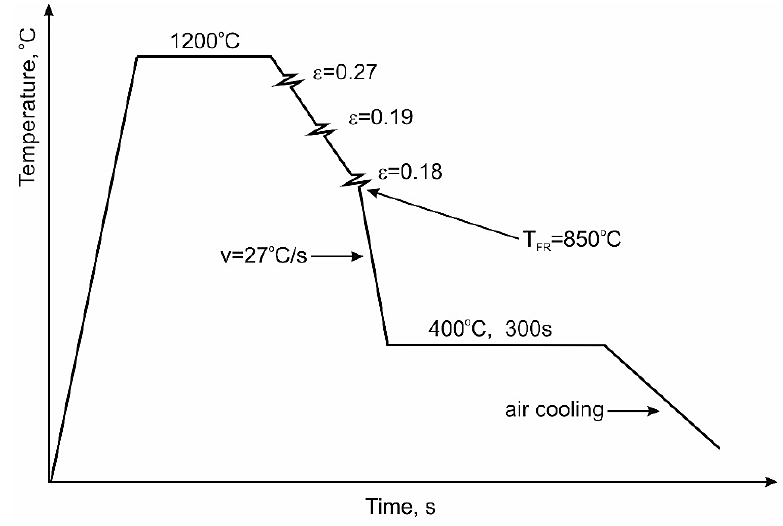
Figure 1. Parameters of thermomechanical processing of investigated steel.